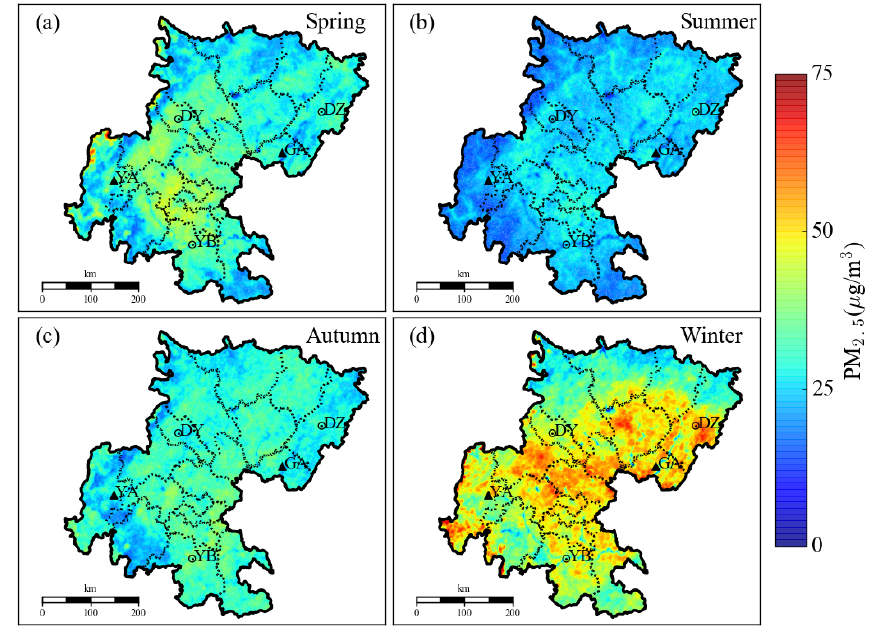
Figure 11. The temopal and spatial distribution of retrieved high-resolution PM 2.5 concentrations across the Sichuan Basin during 1 November 2013 to 31 October 2014. ( a – d ) spring, summer, autumn and winter, respectively.